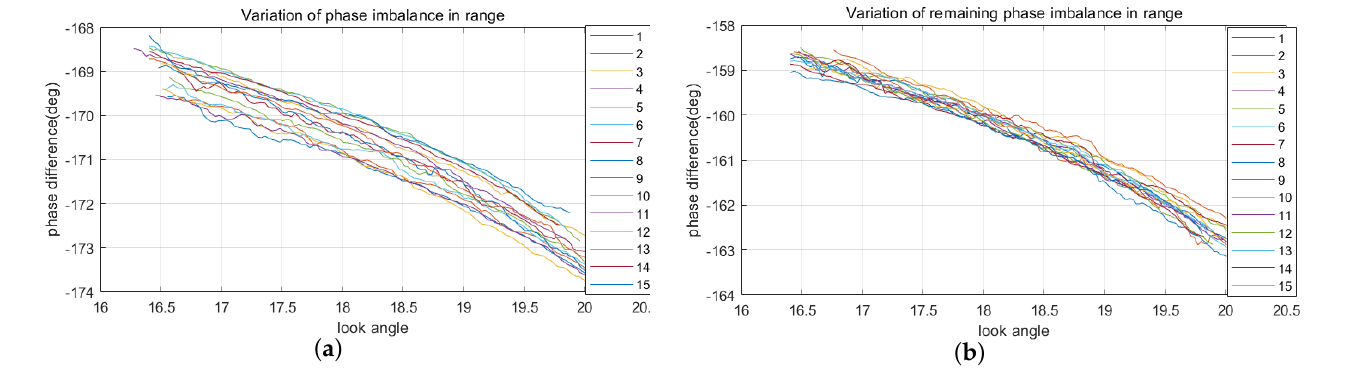
Figure 7. The space-varying of phase imbalances in range. ( a ) The first set of GF-3 ATI data; ( b ) the second set of GF-3 ATI